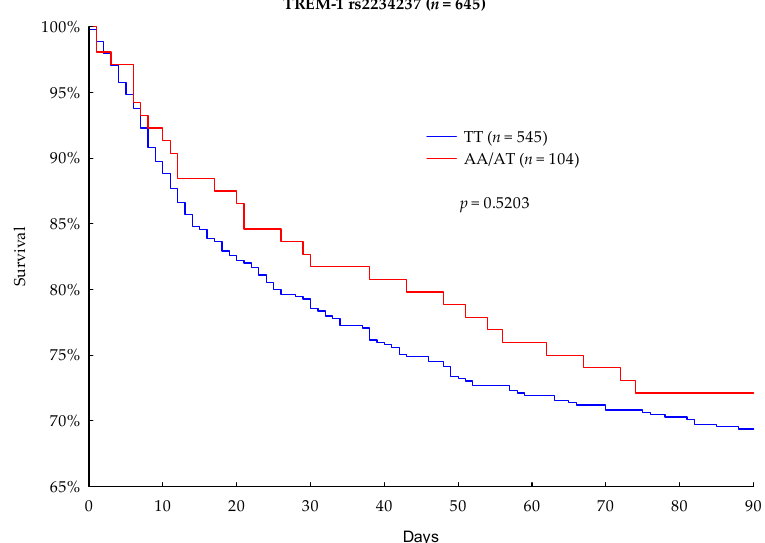
Figure 1: Kaplan–Meier 90-day survival analysis with regard to TREM-1 rs2234237 genotypes Figure 1. Kaplan–Meier 90-day survival analysis with regard to TREM-1 rs2234237